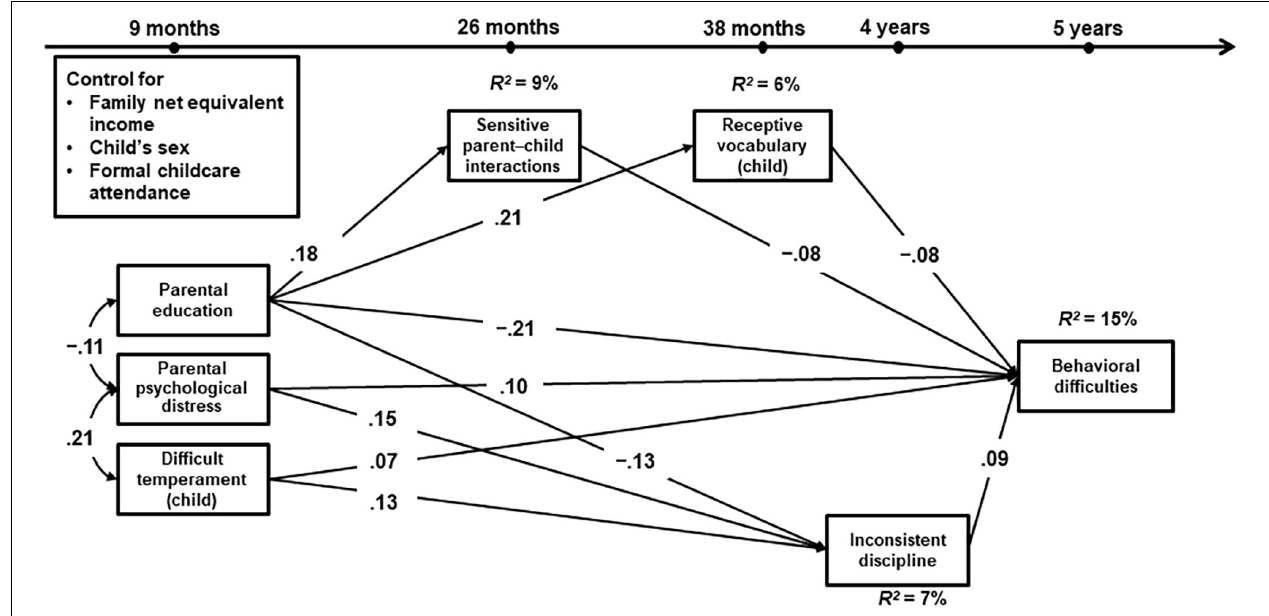
FIGURE 2 | Standardized estimates of the conditional Model A1 using NEPS in Germany. All coefficients are significant at the p < 0.05 level. N = 2,022, χ 2 = 12.133, df = 10, p = 0.35, CFI = 0.995, RMSEA = 0.007, and SRMR =